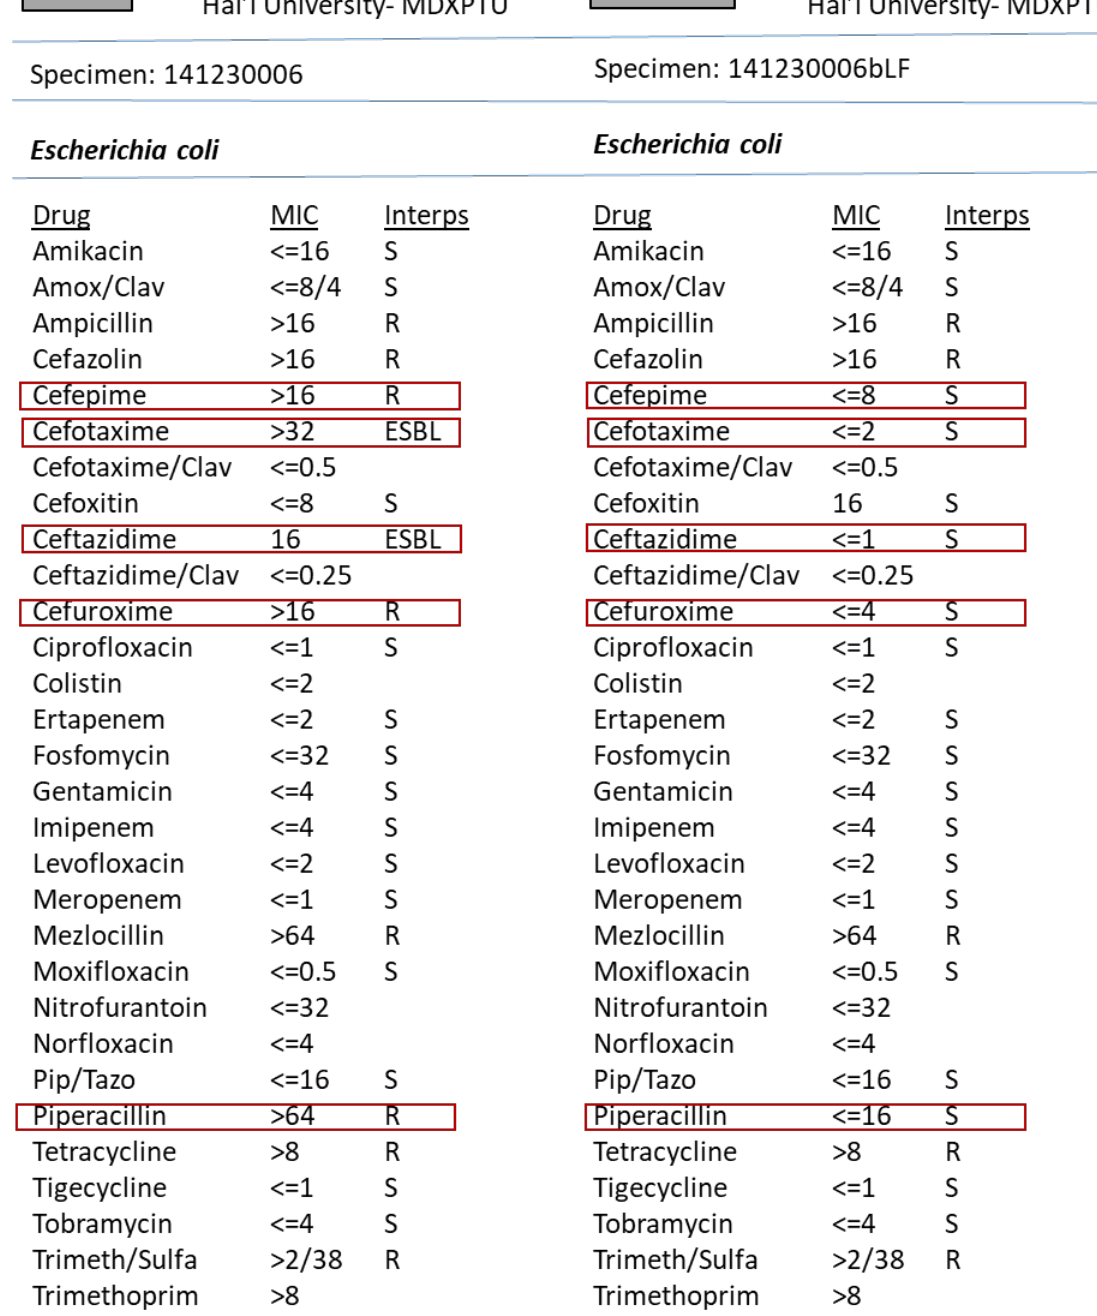
Figure 3. Demonstration of effect of bovine lactoferrin (bLF) on Extended spectrum β -lactamase producing clinical Escherichia